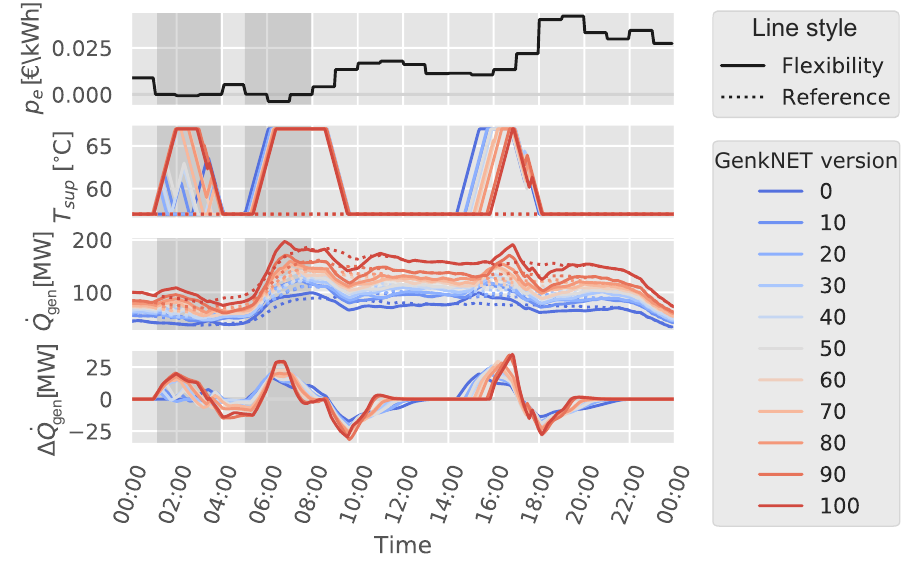
Figure 6. For the Winter_Negp e day, the results of the operational heat pump optimisation for the 11 selected GenkNET versions are shown. From top to bottom, the electricity price, the supply temperature at the plant, the heat injection, and the heat injection response (the difference between the Flexibility and Reference case) are shown. The negative price periods are indicated by the dark grey